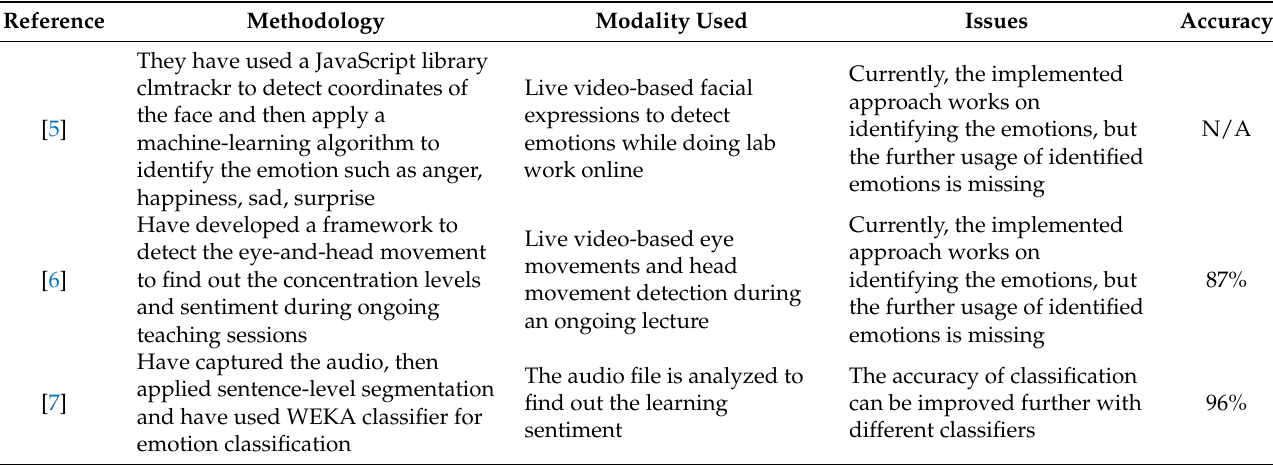
Table 1. Comparison of different studies carried out in